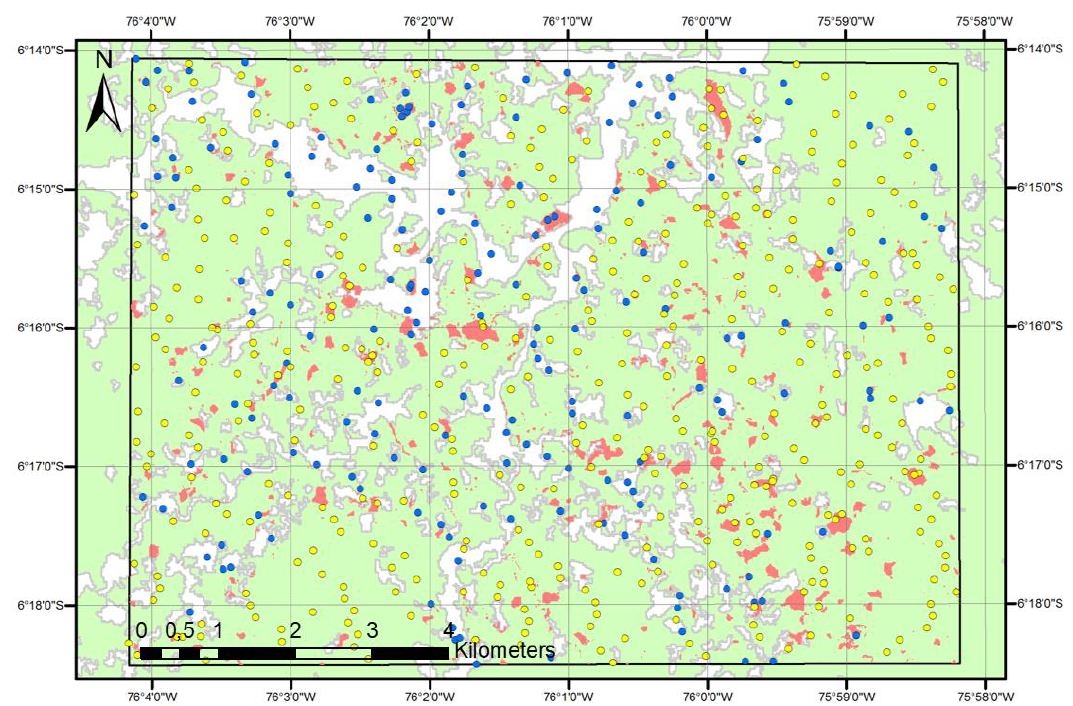
Figure 6. Peru validation site. Green areas show the initial optical forest mask as of 03/2016. Red polygons are the disturbances detected by the “Union” approach. The dots are the 575 validation points from stratified random sampling of which 385 are located within forest in 3/2016 (yellow) and 170 are within non-forest areas (blue) based on visual interpretation of VHR and HR imagery.